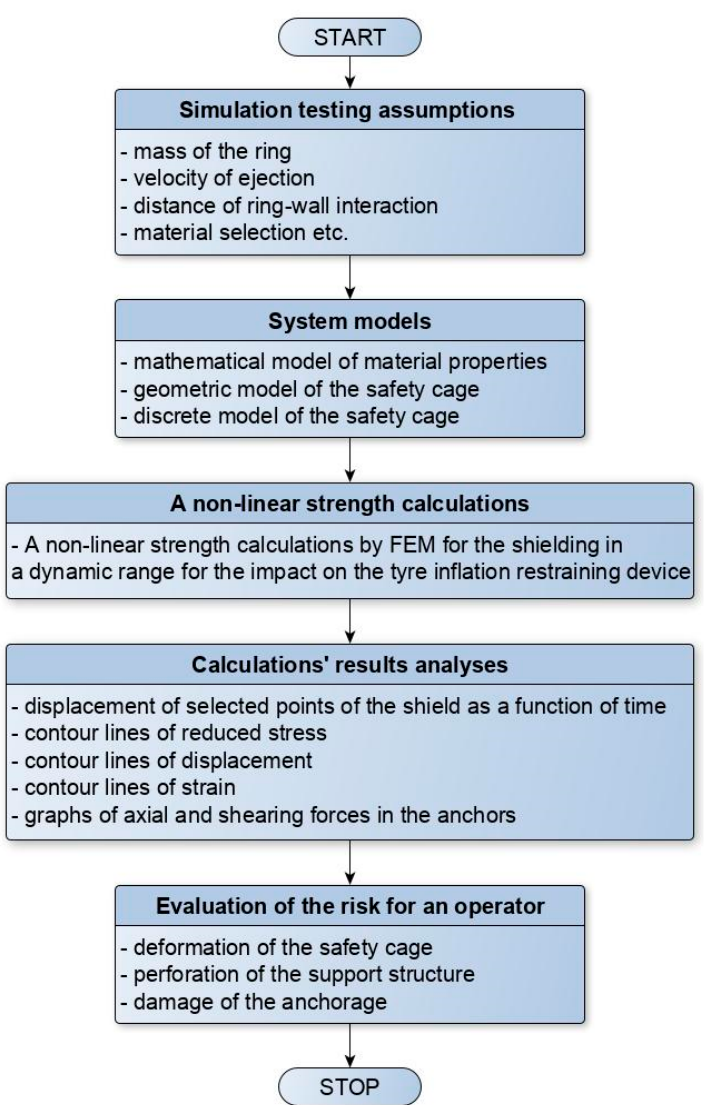
Figure 1. Simulation-based process for evaluating the dynamic strength of tire inflation restraining